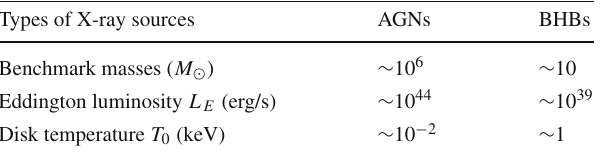
Table 1 Here we list two benchmark points for accreting black hole sources, with the Eddington luminosity and the peaked temperature in thin accreting disk in (3) Types of X-ray